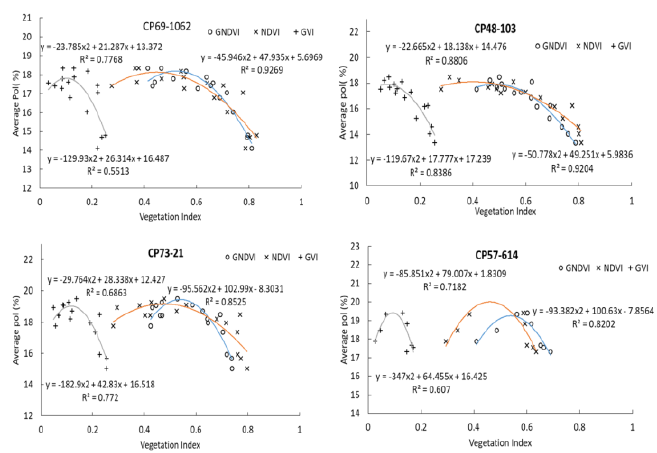
Figure 3. The correlation between the vegetation indices (GNDVI) and pol for CP69-1062, CP48-103, CP73-21 and CP57-614,